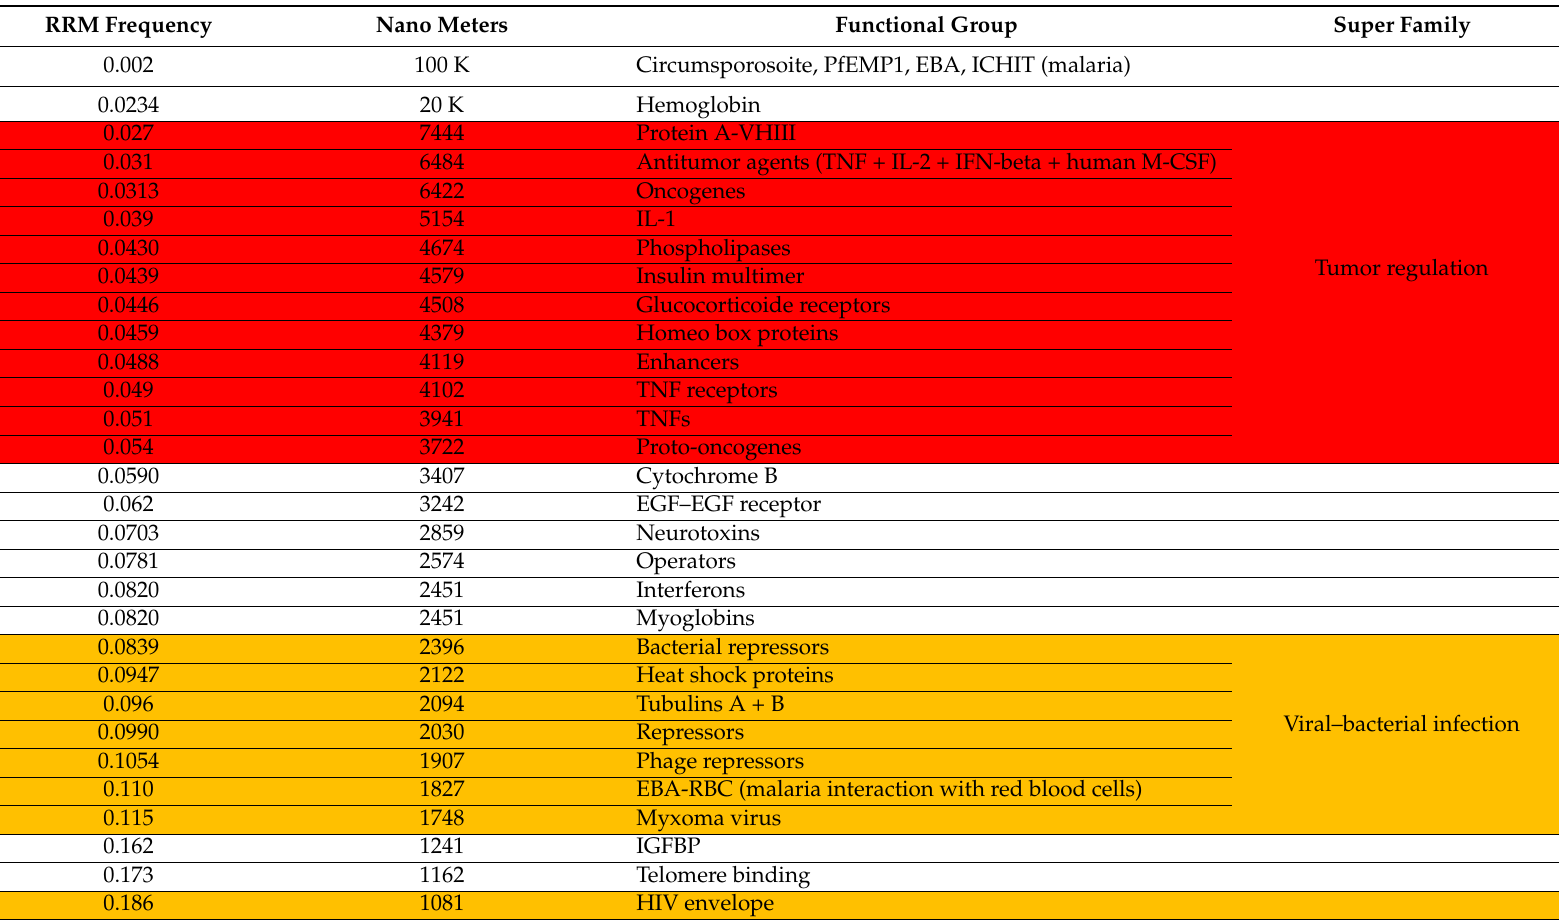
Table 1. Characteristic Resonant Recognition Model (RRM) frequencies for different biological functions of protein and DNA macromolecules. Column 1 represents the numerical RRM frequency. Column 2 represents the corresponding electromagnetic radiation in nm. Column 3 represents name of functional group of proteins and DNA. Column 4 represents super family of number of functional groups, which are also highlighted in different